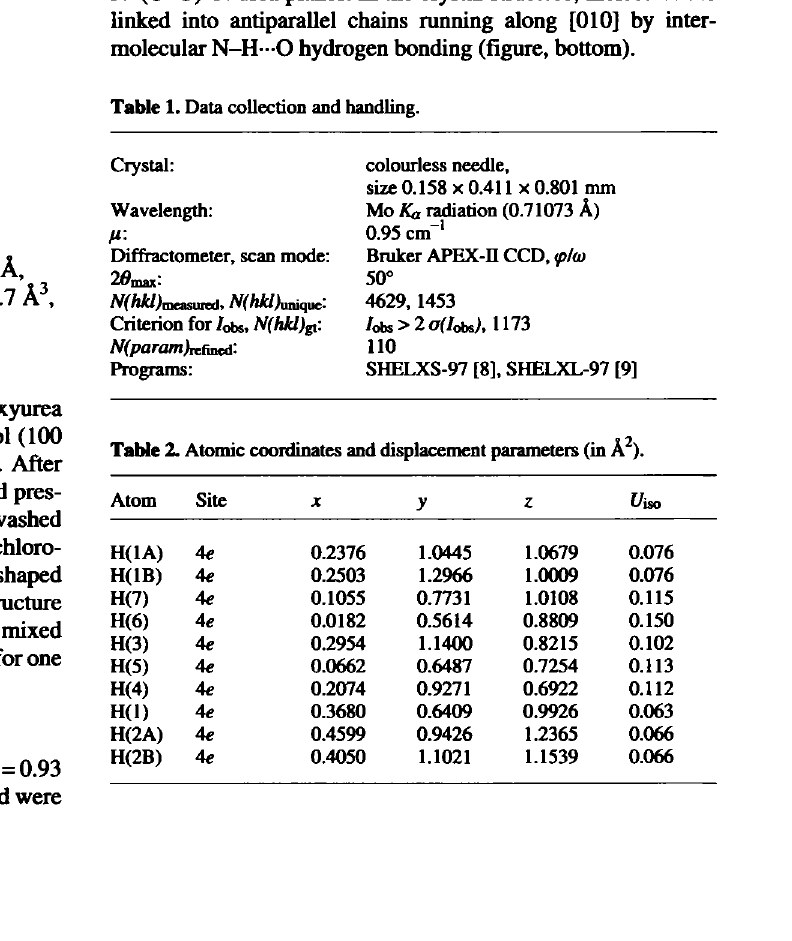
Table 1. Data collection and handling.